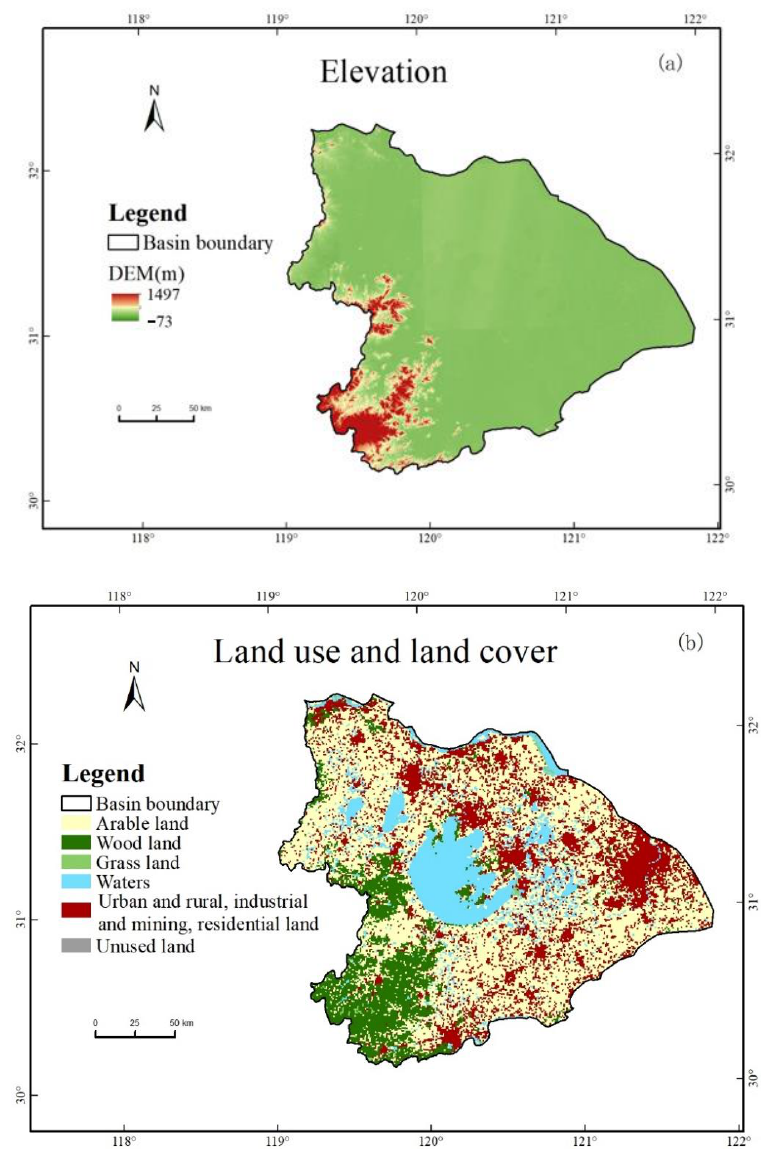
Figure 2. ( a ) Elevation and ( b ) land use and land cover for the Taihu Lake Basin.